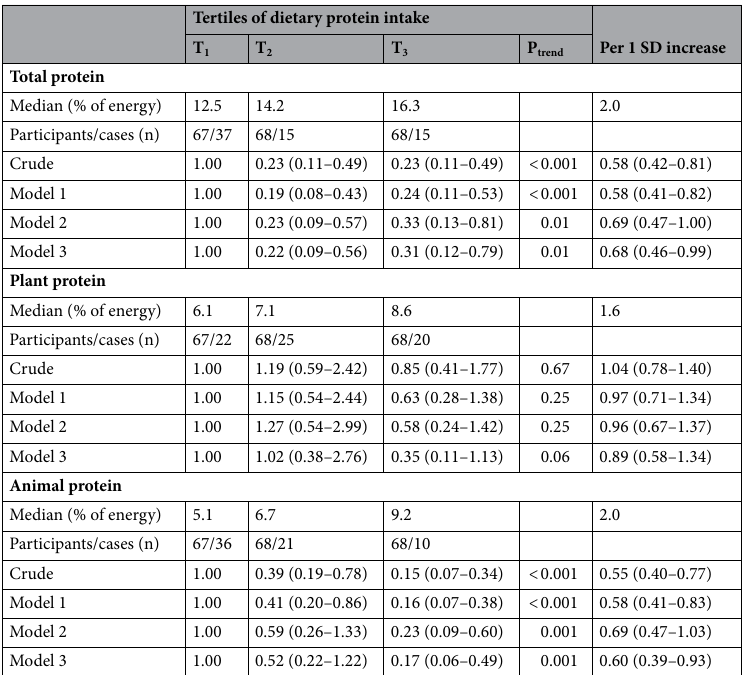
Table 4. Multivariable-adjusted odds ratio for MUO (based on IDF/HOMA-IR criteria) across tertiles of dietary total, plant, and animal protein intake (n = 203) 1 . 1 All values are odds ratios and 95% confidence intervals. Model 1: Adjusted for age, gender, energy intake. Model 2: More adjustments for physical activity levels, socioeconomic status. Model 3: Further adjustments for total dietary fat intake, plant protein (for animal protein), animal protein (for plant protein) and